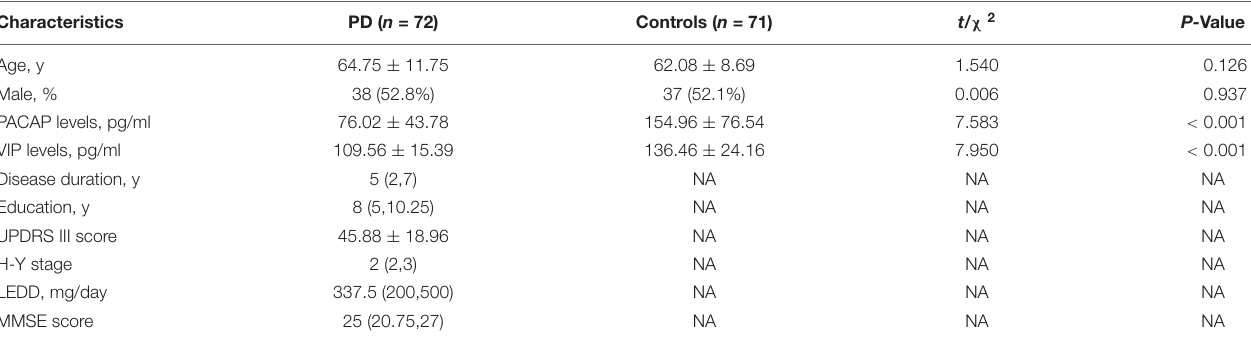
TABLE 1 | Clinical characteristics and serum PACAP and VIP levels of participants in individual groups in the current study.